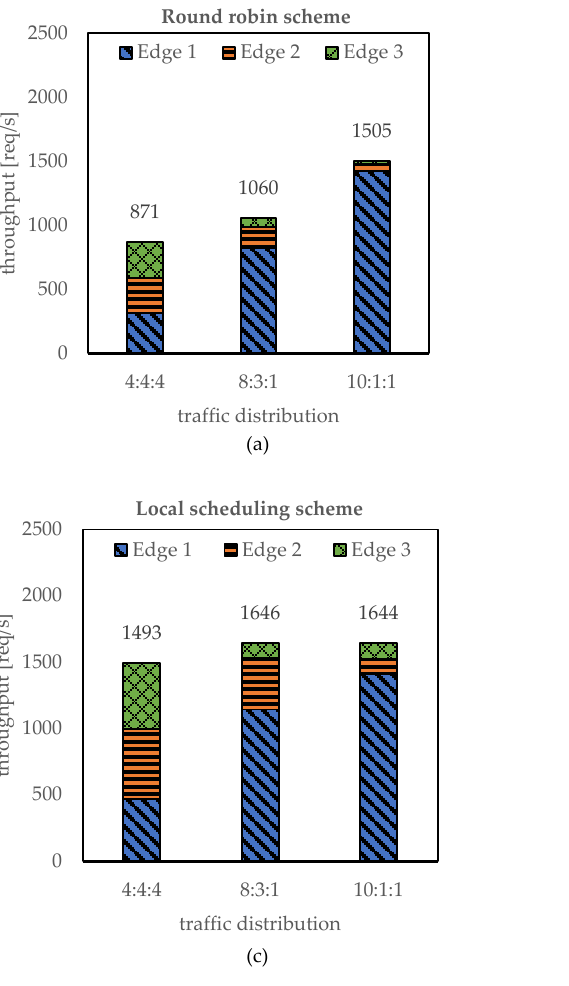
Figure 7. Throughput and average response time according to the load-balancing schemes ( a , c ): round-robin scheme, ( b , d ): local scheduling scheme.